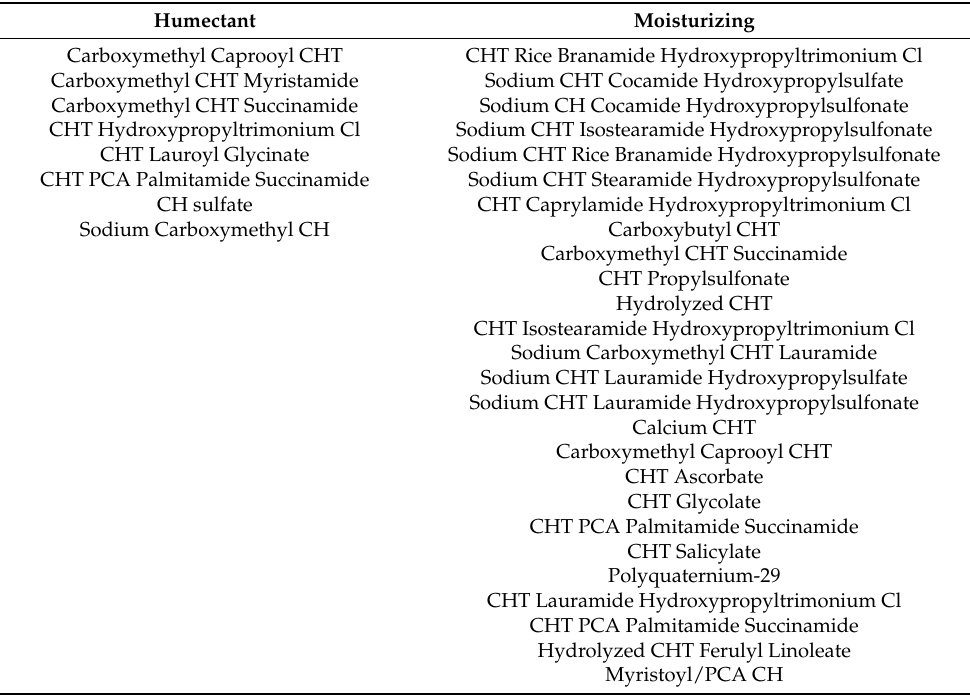
Table 10. Chitin and chitosan derivatives with humectant or moisturizing activity included in CosIng